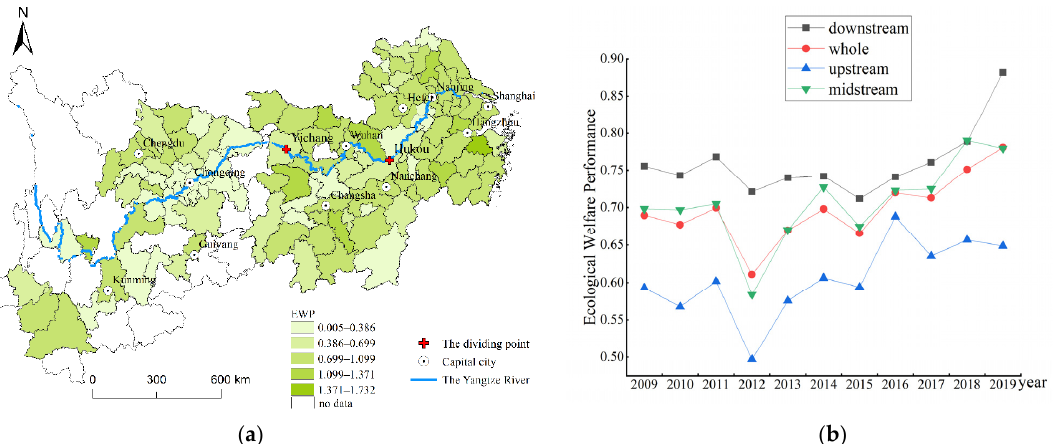
Figure 2. Distribution map of EWP in 2019 ( a ) and its dynamic changes ( b ) in the